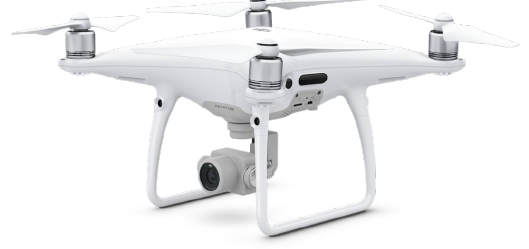
Figure 5. DJI Phantom 4 Pro (DJI, 2022).